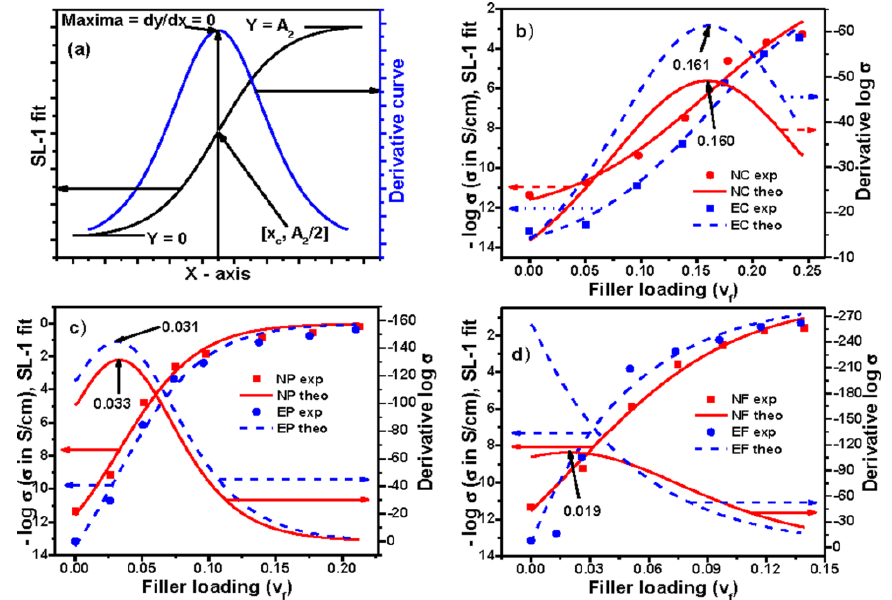
Figure 8. Experimental, theoretical, and derivative curves: ( a ) an ideal curve; ( b ) Conductex black filled; ( c ) Printex black filled; and ( d ) SCF filled composites based on Sigmoidal–Logistic-1 model.